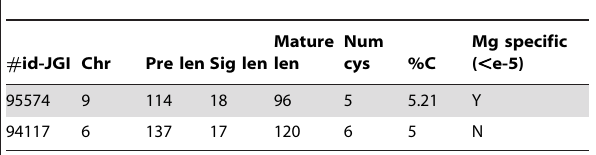
Table 7. The predicted , 200 amino acid cysteine-rich proteins ( . 5% cys) from M. graminicola isolate IPO323.